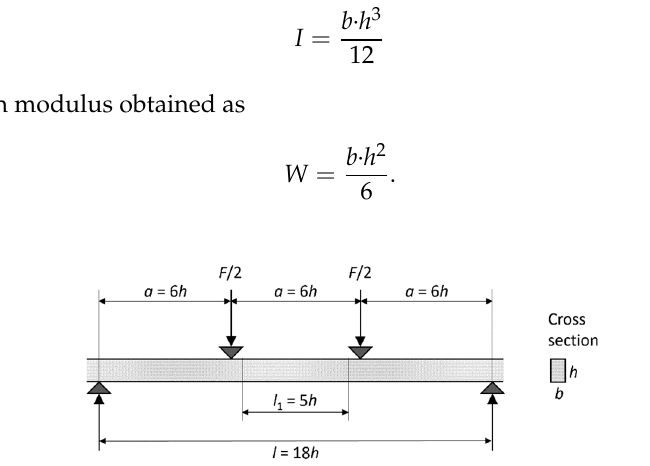
Figure 2. Schema of four-point bending test according to EN408, where F is load increment, a is distance between load points, l 1 is central gauge length, l is test span, h is board width and b is board thickness.